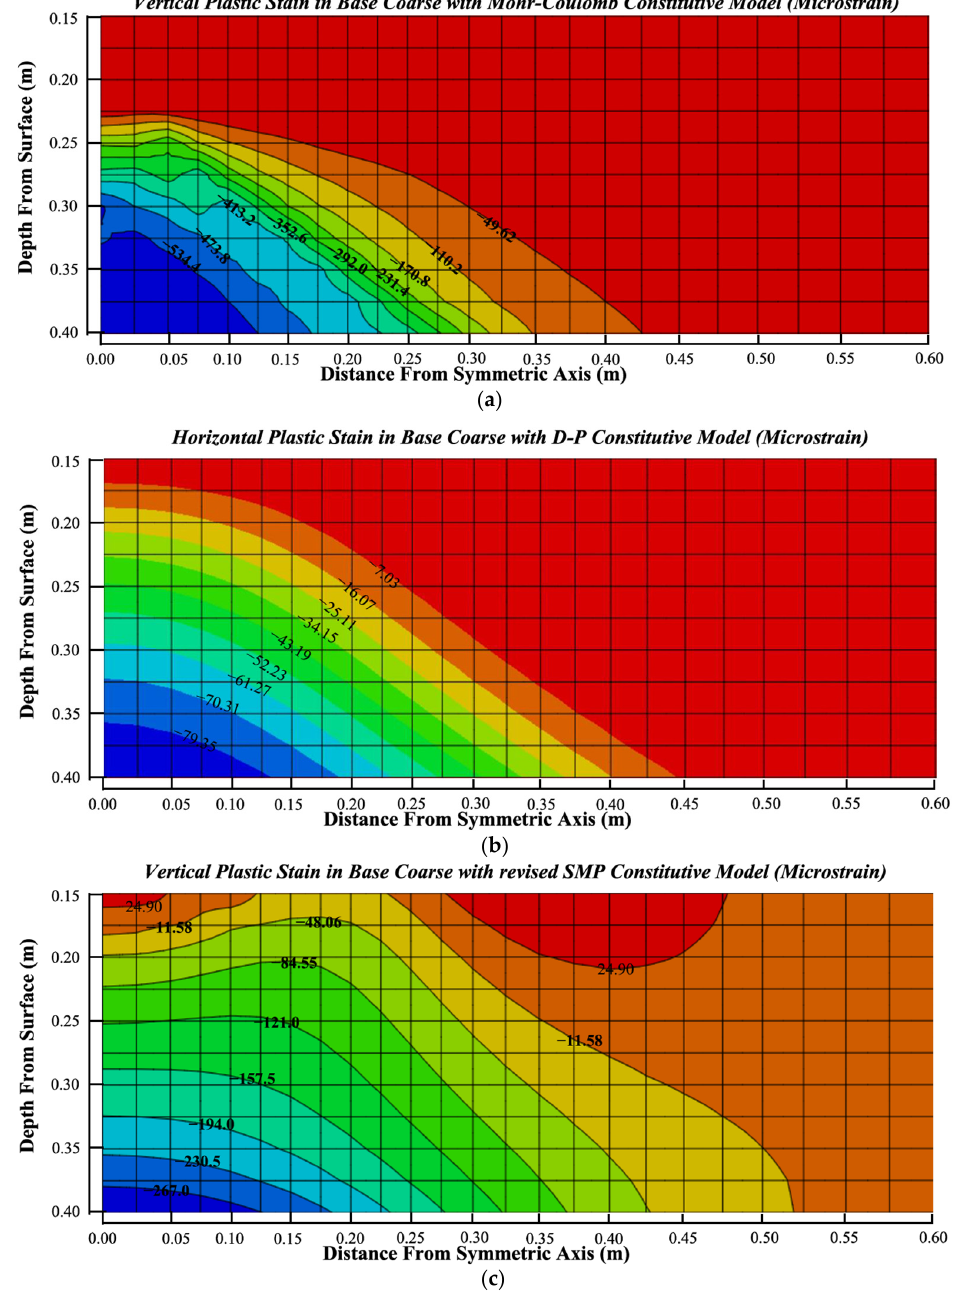
Figure 6. Distribution of vertical nominal plastic strain of UGM layer with the three models ( a ) Mohr-Coulomb model, ( b ) Druck-Prager model, ( c ) Revised SMP model. The variation of the vertical plastic strain along the depth is shown in Figure 7, where the strains increase gradually and the change rate of plastic strains is higher near the cen- terline of the loading area. When the Mohr-Coulomb and Druck-Prage models were used, there was almost no vertical plastic strain in the depth range of 0~7.5 cm from UGM top surface. After that, the plastic strain produced by the Mohr-Coulomb model increased sharply. The plastic compressive strain at the bottom of UGM layer reached 595 µ ε in R0, and it was up to 509.8 µ ε in R15. The plastic compressive strain for the revised SMP model was 303.4 µ ε at R0, and 253.7 µ ε at R15, respectively. The plastic strains were about half of that from Mohr-Coulomb model. However, the plastic strain of Druck-Prage model was much smaller than that of the other two models. Along with the increase of depth, the variation of plastic strain linearly increased. This was due to the Druck-Prage criterion considered the intermediate principle stress compared with the Mohr-Coulomb model. Under condition of three-direction stress, the strength and stiffness of the UGM layer was enhanced so that the plastic strain was much smaller. In addition, the Druck-Prage crite- rion had no angle resulting in a smooth distribution of the plastic strain. As for the revised SMP model, the stiffness of the revised SMP model increased gradually along with the loading cycles. In the initial state, the calculated modulus of the revised SMP model was relatively lower. However, the Druck-Prage model had a sharp increased stiffness due to the three-direction stress, and it hardly varied along with the loading cycles. Therefore, the plastic strain of Druck-Prage model was smaller than that of the revised SMP model. Using the revised SMP model, the vertical plastic tensile strains were 55.5 µ ε and 42.3 µ ε at two sides of the loading area on the surface of UGM layer. This showed that the revised SMP model had the possibility of arching. It had strong relevance with the shear